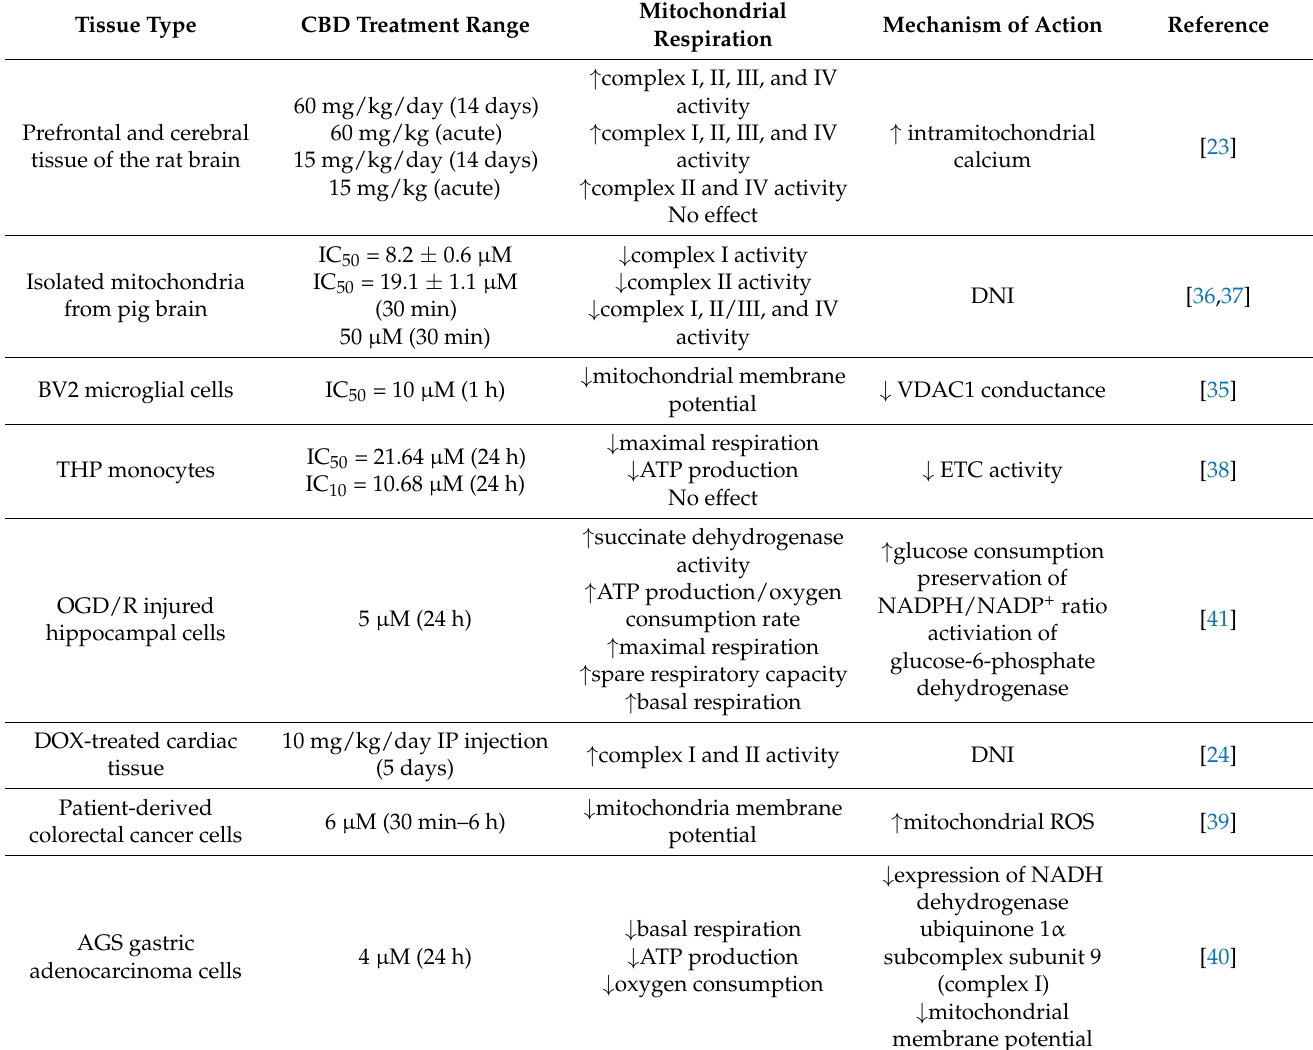
Table 2. Effects of CBD on mitochondrial